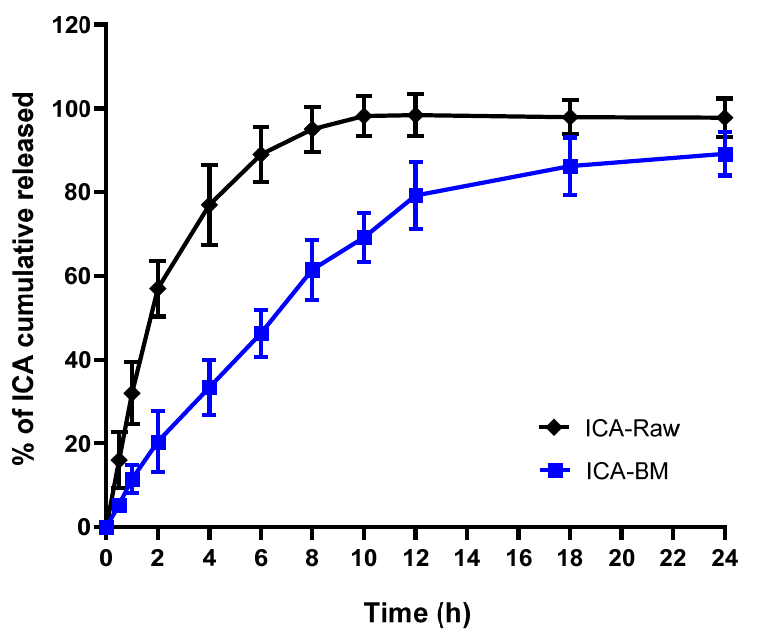
Figure 3. In vitro release profile of optimized ICA-BM.